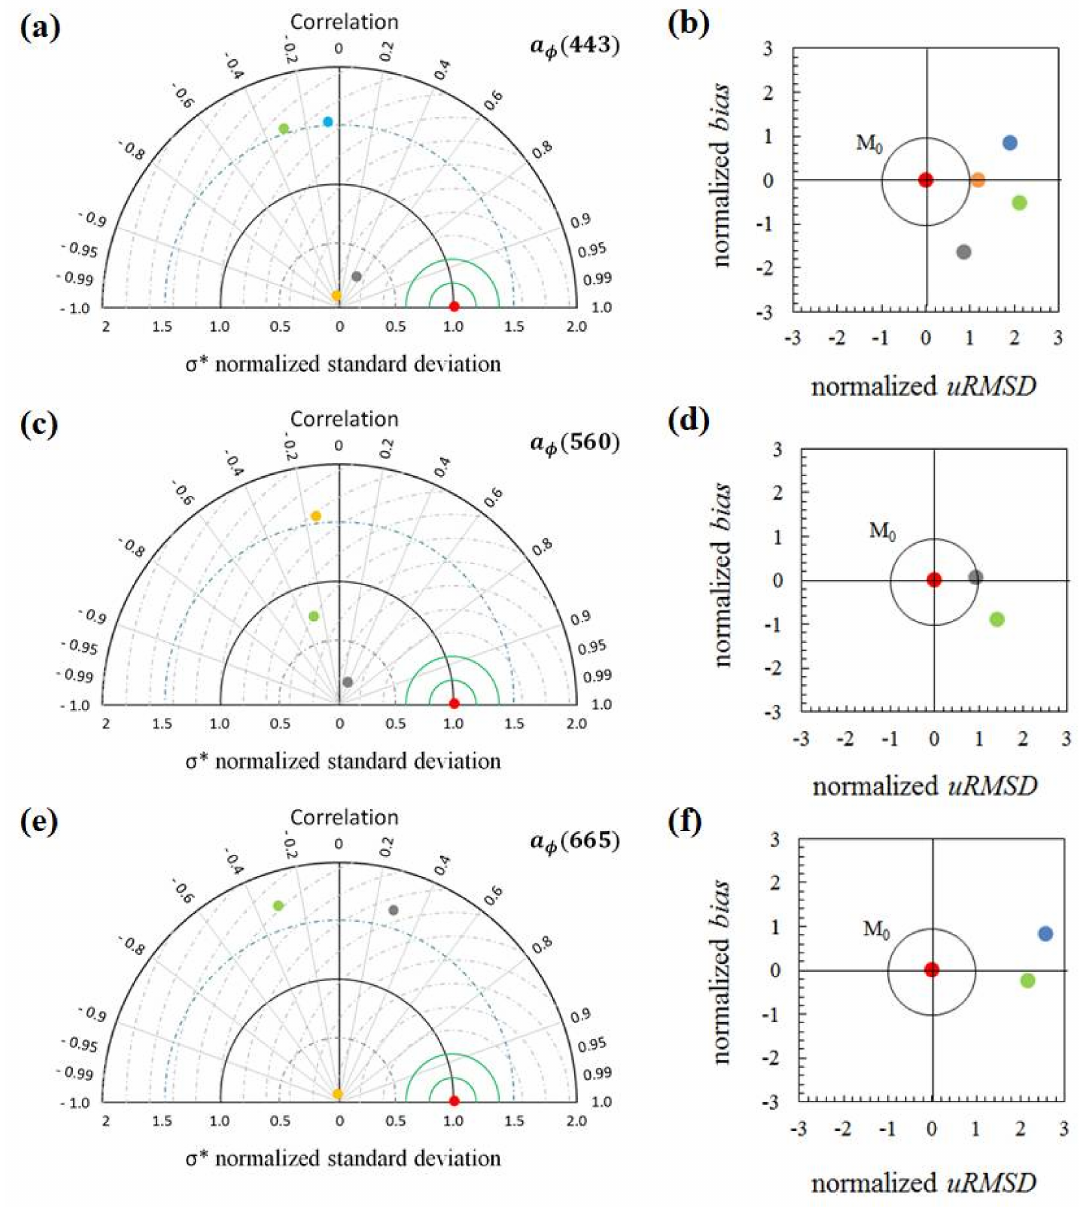
Figure 6. Taylor diagrams for a φ ( λ ) at ( a ) 443 nm, ( c ) 560 nm, and ( e ) 665 nm. Target diagrams also for a φ ( λ ) at ( b ) 443 nm, ( d ) 560 nm, and ( f ) 665 nm. Symbols indicate the following: QAA Lv5 (gray dot), QAA Lv6 (yellow dot), QAA M14 (blue dot), the QAA OMW (green dot), and the reference observation (red